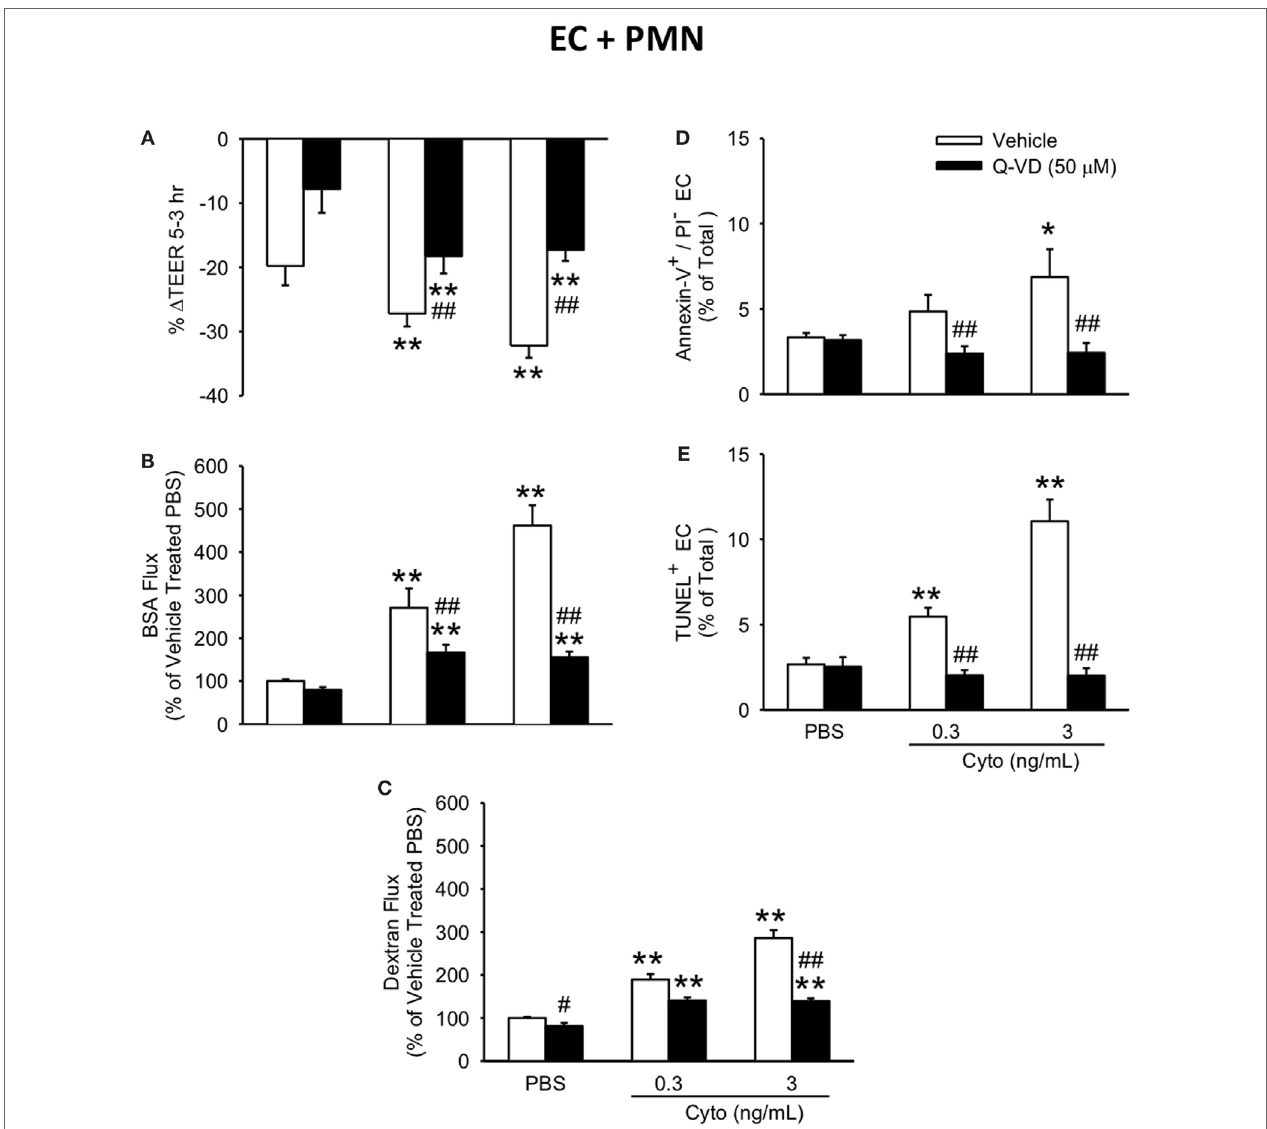
FigUre 7 | Inhibition of caspase activity in human PMVEC cocultured with PMN reduces septic hyper-permeability and apoptosis. Treatment of PMN–PMVEC cocultures with Q-VD (50 μ M) significantly attenuated the septic decreases in transendothelial electrical resistance (TEER) (a) as well as the septic increases in macromolecular flux, including Evans blue-bovine serum albumin (BSA) (B) and fluoroisothiocyanate-dextran (c) vs. vehicle treatment (dimethyl sulfoxide). Furthermore, Q-VD treatment of PMVEC cultured with PMN also significantly blunted the septic increase in the number of Annexin-V + /propidium iodide (PI) − (D) and TUNEL + (e) cells. * p < 0.05 and ** p < 0.01 compared with respective PBS-treated group; ## p < 0.01 compared with respective vehicle-treated group (two-way ANOVA). n =